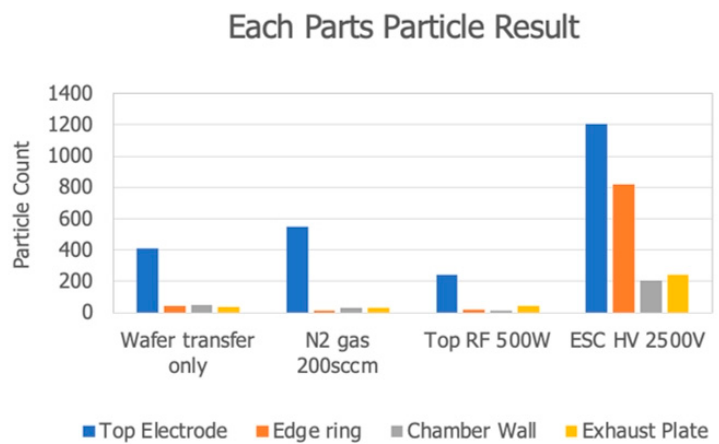
Figure 6. Wafer particle counts when powder was spread over the surfaces of four chamber parts.